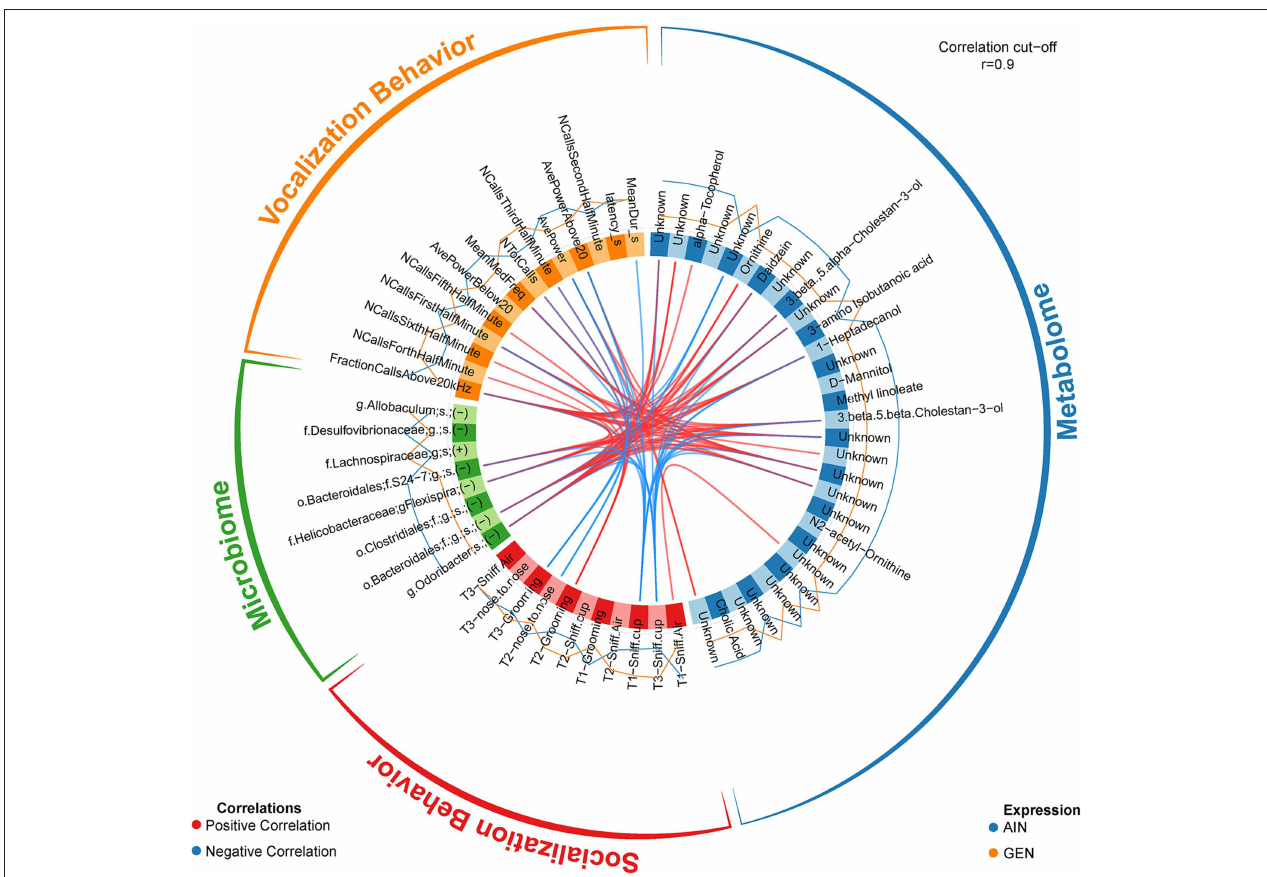
FIGURE 2 | Circos correlations as determined with mixOmics analyses (72) for behavioral responses, gut microbiome, and gut metabolome changes in GEN exposed males vs. AIN (control) male California mice. Adapted from Marshall et al. (46) with permission from BioScientifica Limited.